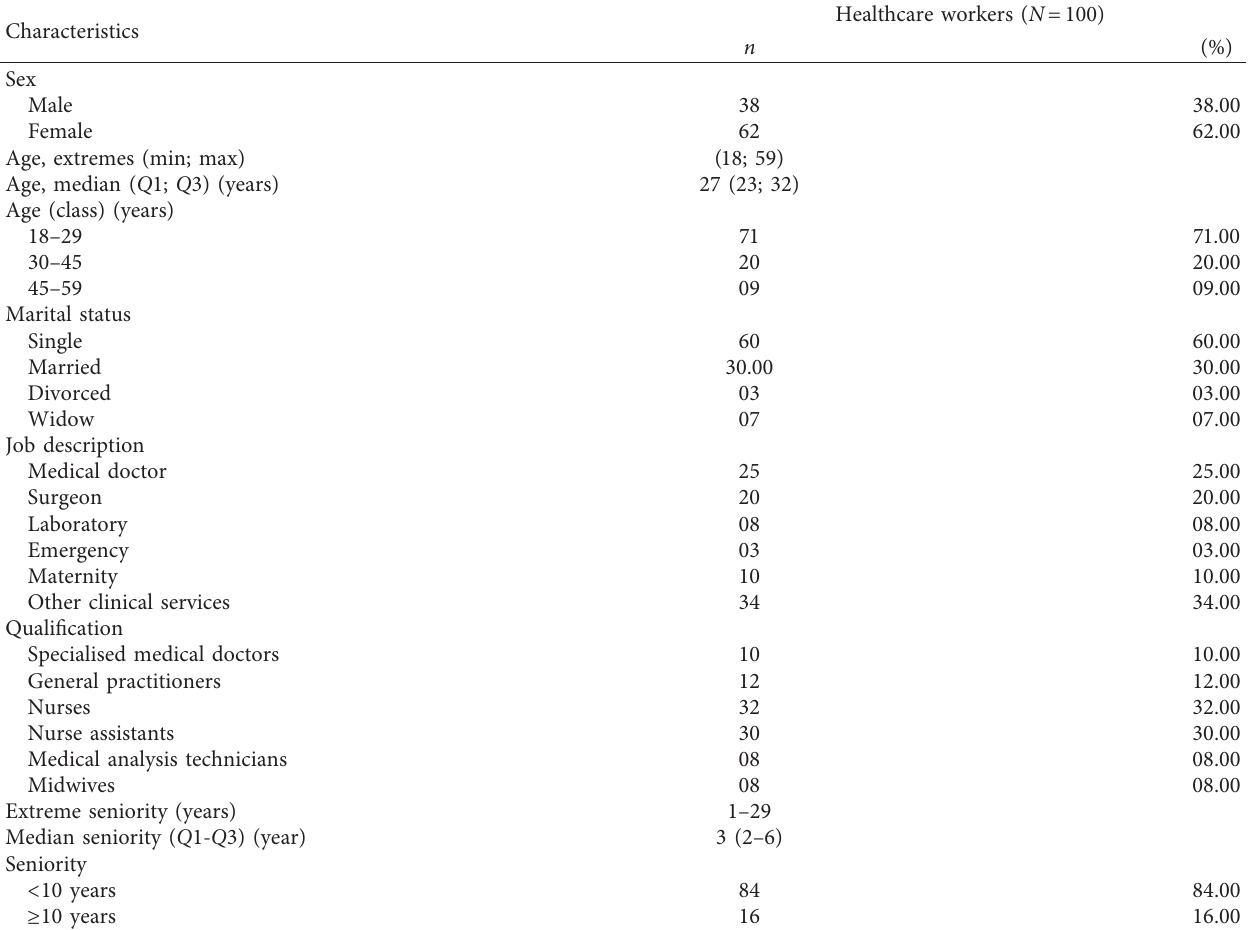
Table 1: Sociodemographic and professional characteristics of healthcare